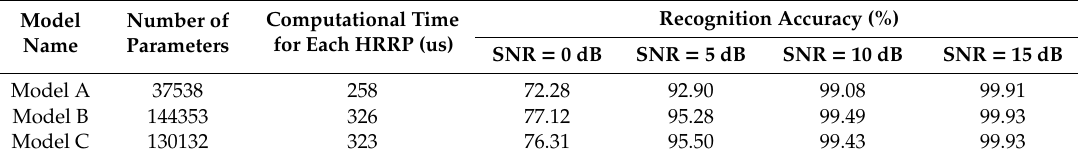
Table 10. Recognition accuracy of di ff erent complexity models under di ff erent SNR